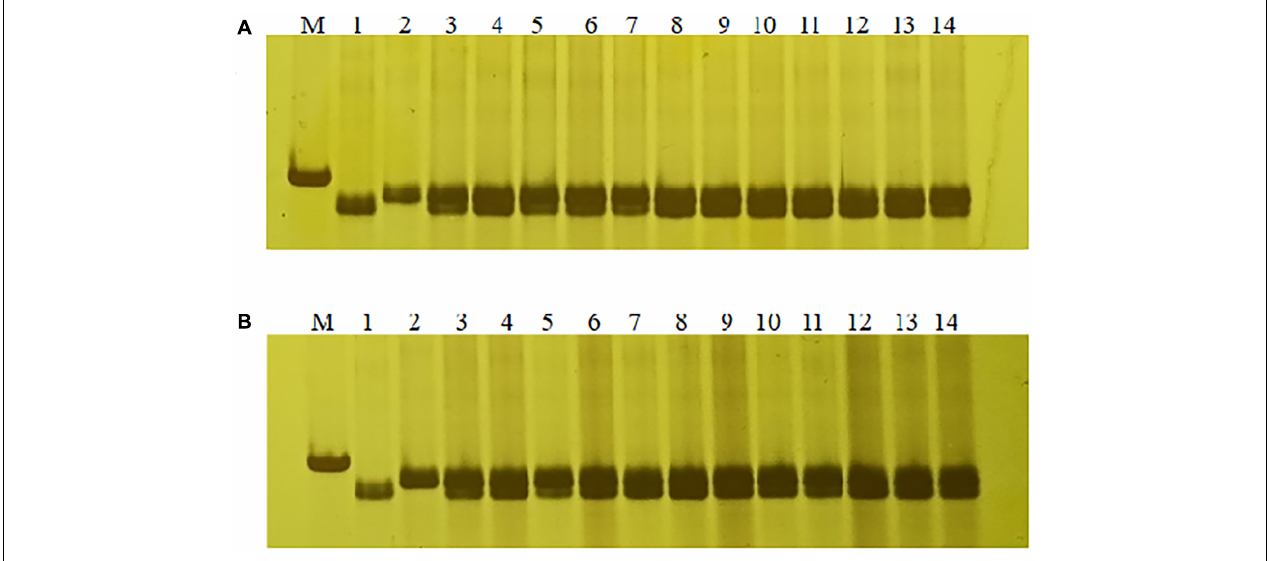
FIGURE 7 | Marker-assisted selection of Lr65 with diagnostic marker 1500-1. (A) Selection of Lr65 in “Xuexao/Altgold//Shiyou 20” population. 1: a resistant progeny of Xuexao/Altgold, 2: Shiyou20, 3–14: the resistant plants among the progenies. (B) Selection of Lr65 in “Xuexao/Altgold//Zhongmai 1062” population. 1: a resistant progeny of Xuexao/Altgold, 2: Zhongmai1062, 3–14: the resistant plants among the progenies. M is